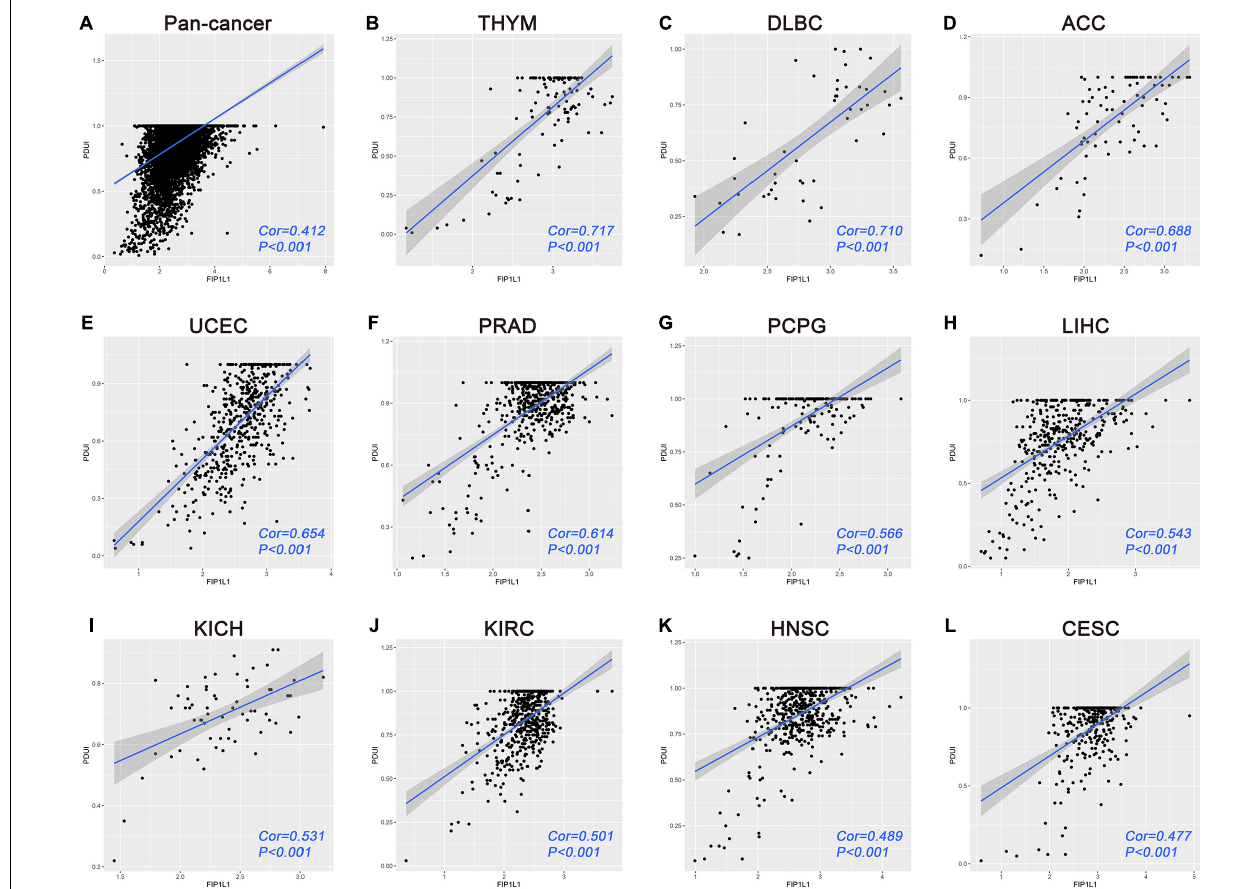
FIGURE 8 | Pan-cancer analyses of FIP1L1-VPS26B regulating relationship. (A) Correlation analysis of FIP1L1-VPS26B in 9087 patients indicated that the expression of FIP1L1 is significantly associated with the PDUI of VPS26B. (B–L) Correlation results of top 11 cancer in 30 cancer types.